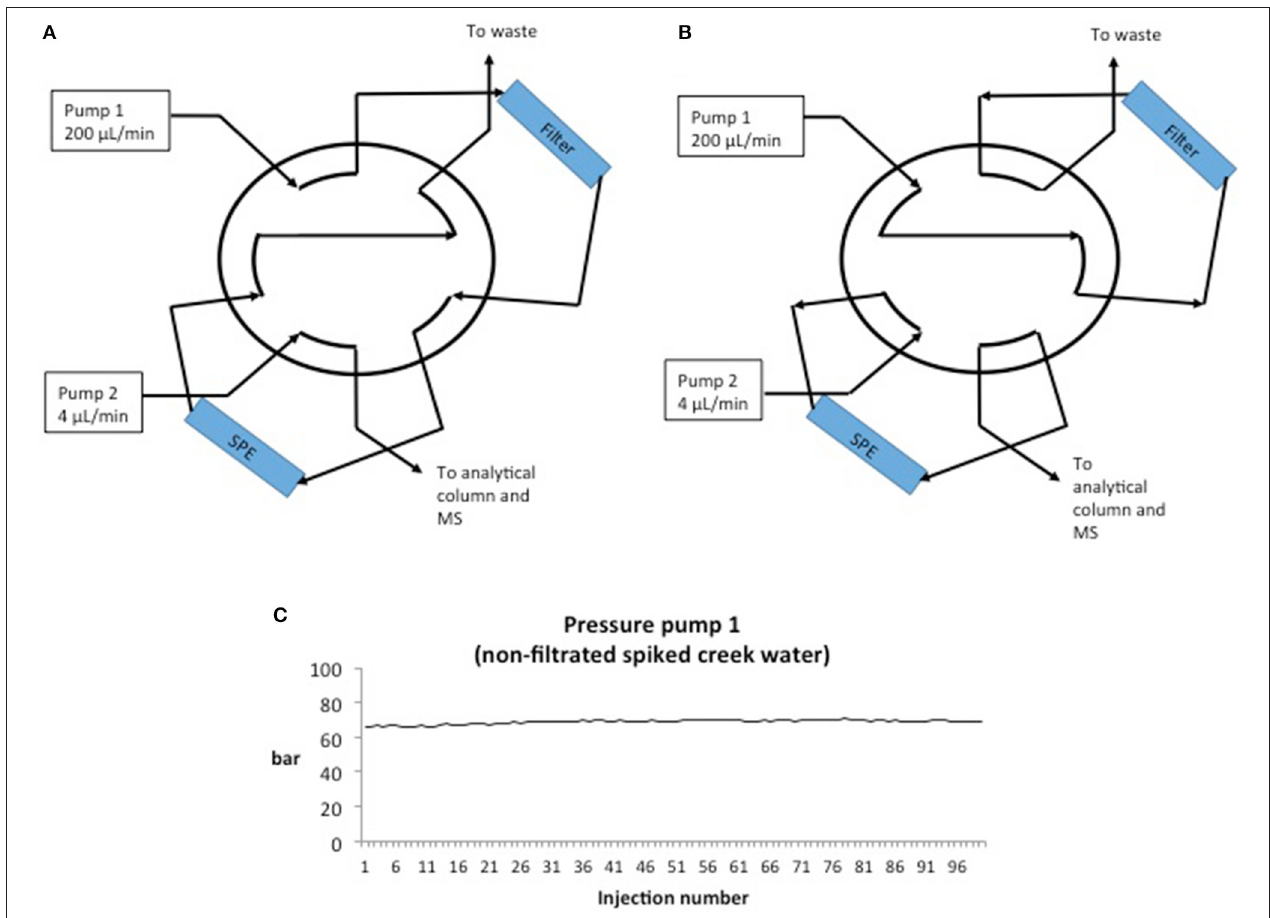
FIGURE 1 | (A) AFFL-SPE in load position. Solutions (100 µ L) are injected by an autosampler and transferred through the filter and on to the SPE column by Pump 1 (200 µ L/min). Particles are stopped by the filter, while analytes are trapped on the SPE column. (B) AFFL-SPE in inject position. Pump 2 (4 µ L/min) elutes analytes from SPE and on to the analytical column for separation and MS for detection. Simultaneously, pump 1 back-flushes the filter, washing particles out to waste. (C) Pressure on the SPE column/pump 1 in inject position while injecting 100 non-filtrated spiked creek water